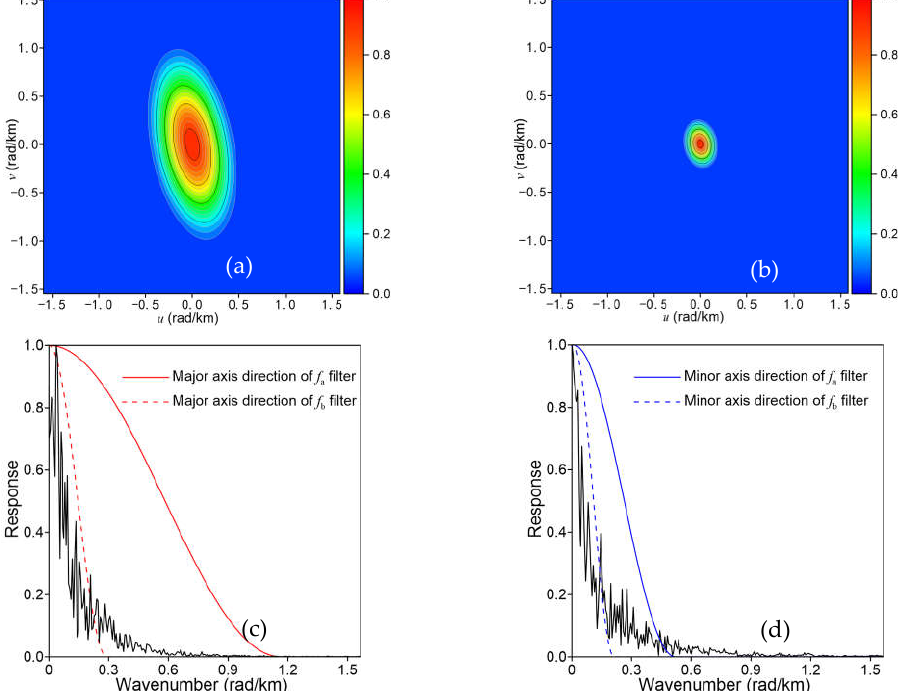
Figure 5. The response of the f a and f b filters. ( a ) The response of the f a filter. ( b ) The response of the f b filter. ( c ) The response of the f a and f b filter in the direction of the major axis. The solid red line and the dashed red line represent the response of the f a and f b filters in the direction of the major axis, respectively. The solid black line represents the normalized amplitude spectrum of the magnetic anomalies of the SCS in the direction of the major axis. ( d ) The response of the f a and f b filters in the direction of the minor axis. The solid blue line and the dashed blue line represent the response of the f a and f b filters in the direction of the minor axis, respectively. The solid black line represents the normalized amplitude spectrum of the magnetic anomalies of the SCS in the direction of the minor axis.